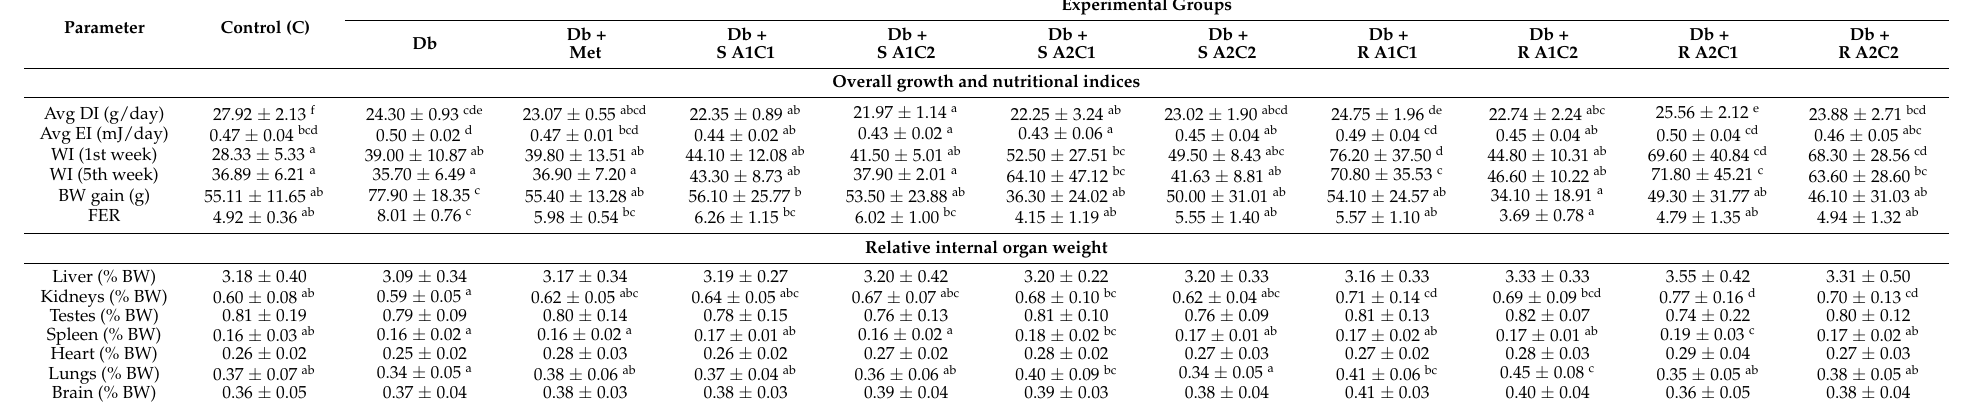
Table 1. Effects of the diet and combined SG, L-Arg and Cr(III) supplementation on overall growth indices and the relative organ weight in rats.